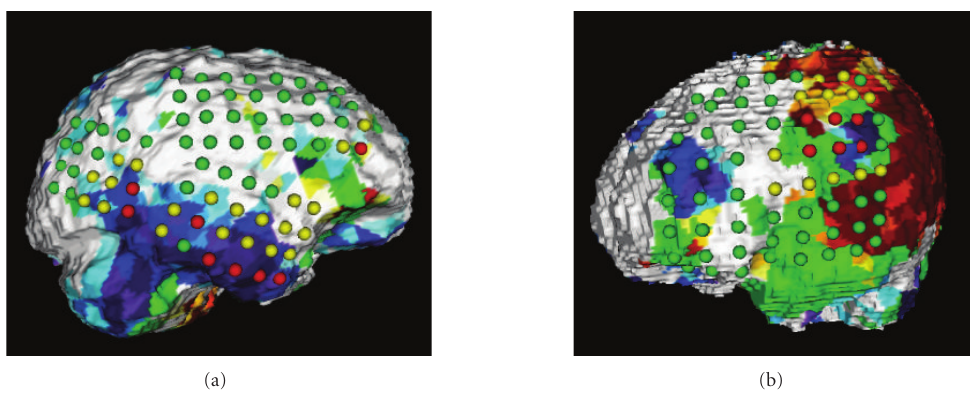
Figure 7: (a) Surface rendering of a patient’s brain with an epileptic focus in the right temporal lobe. Finite cortical elements which represent abnormally decreased FDG PET tracer uptake are rendered as blue areas with dark blue representing the most severe decrease and with light blue representing the least severe decrease. The location of FDG PET abnormalities can be assessed with respect to the location of seizure onset electrodes (red) and seizure spread electrodes (yellow). The SPIonset for this patient was calculated as 2.75. (b) Surface rendering of a patient with tuberous sclerosis who had cortical tubers in the frontal and parietal lobes. Both tubers are associated with abnormally decreased FDG tracer uptake (blue areas). Furthermore, yellow, orange, and red areas represent various degrees of abnormally increased FDG tracer uptake, whereas green areas represent areas with abnormally homogeneous FDG tracer uptake and may indicate dysplastic tissue. Onset electrodes (red) were located near the tuber in the parietal lobe and this area was determined as epileptogenic. The relevance of abnormally increased FDG tracer uptake adjacent to epileptogenic tubers is at present unclear and warrants future